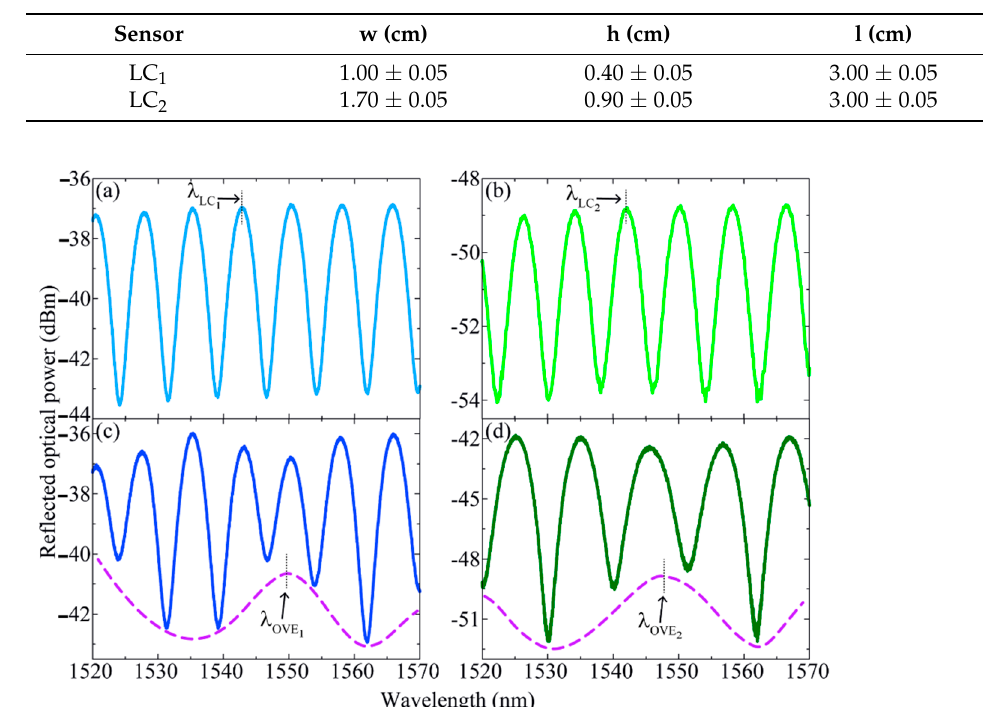
Figure 4. Spectra of ( a ) LC 1 , ( b ) FPI 2 , ( c ) VFPI 1 and ( d ) VFPI 2 . The purple dashed lines in ( c , d ) represent the lower envelopes of the spectra. λ LC1,2 and λ OVE1,2 are the monitored central wavelengths of the FPIs and OVEs’ envelopes, respectively, used in the sensors’ characterizations.